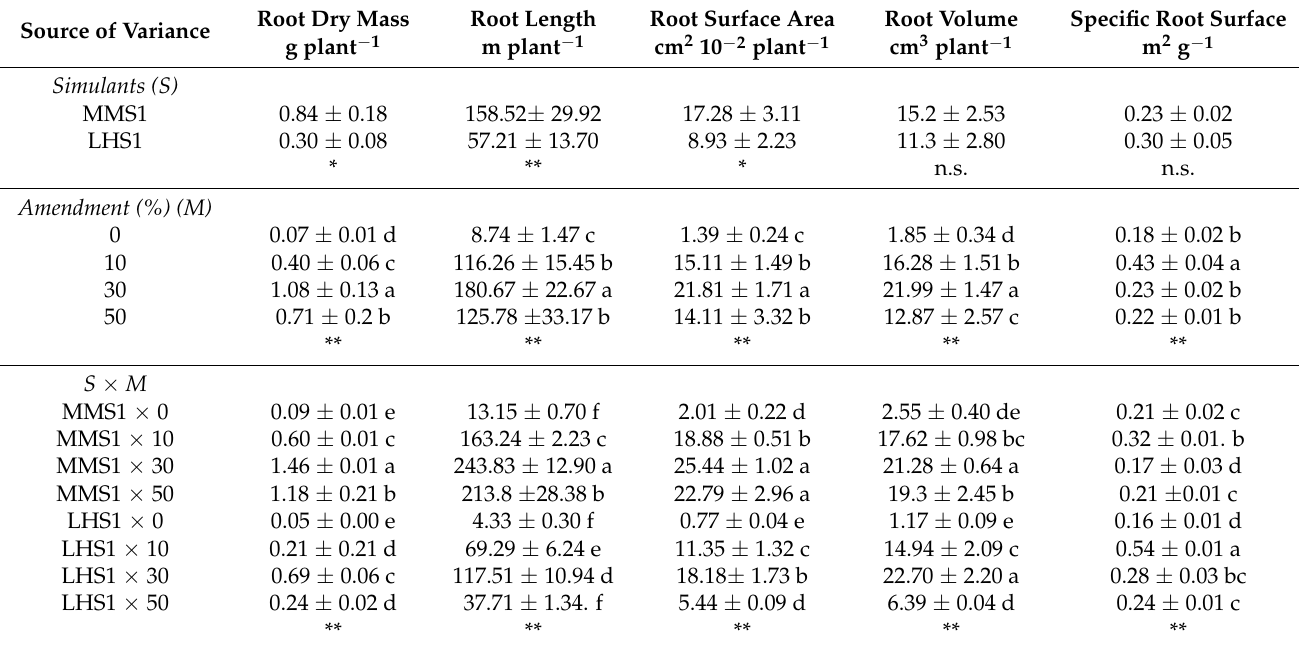
Table 2. Root biometric parameters in different mixtures of MMS-1 or LHS-1 simulants and manure (simulant/manure rates: 100:0, 90:10, 70:30, 50:50; w / w